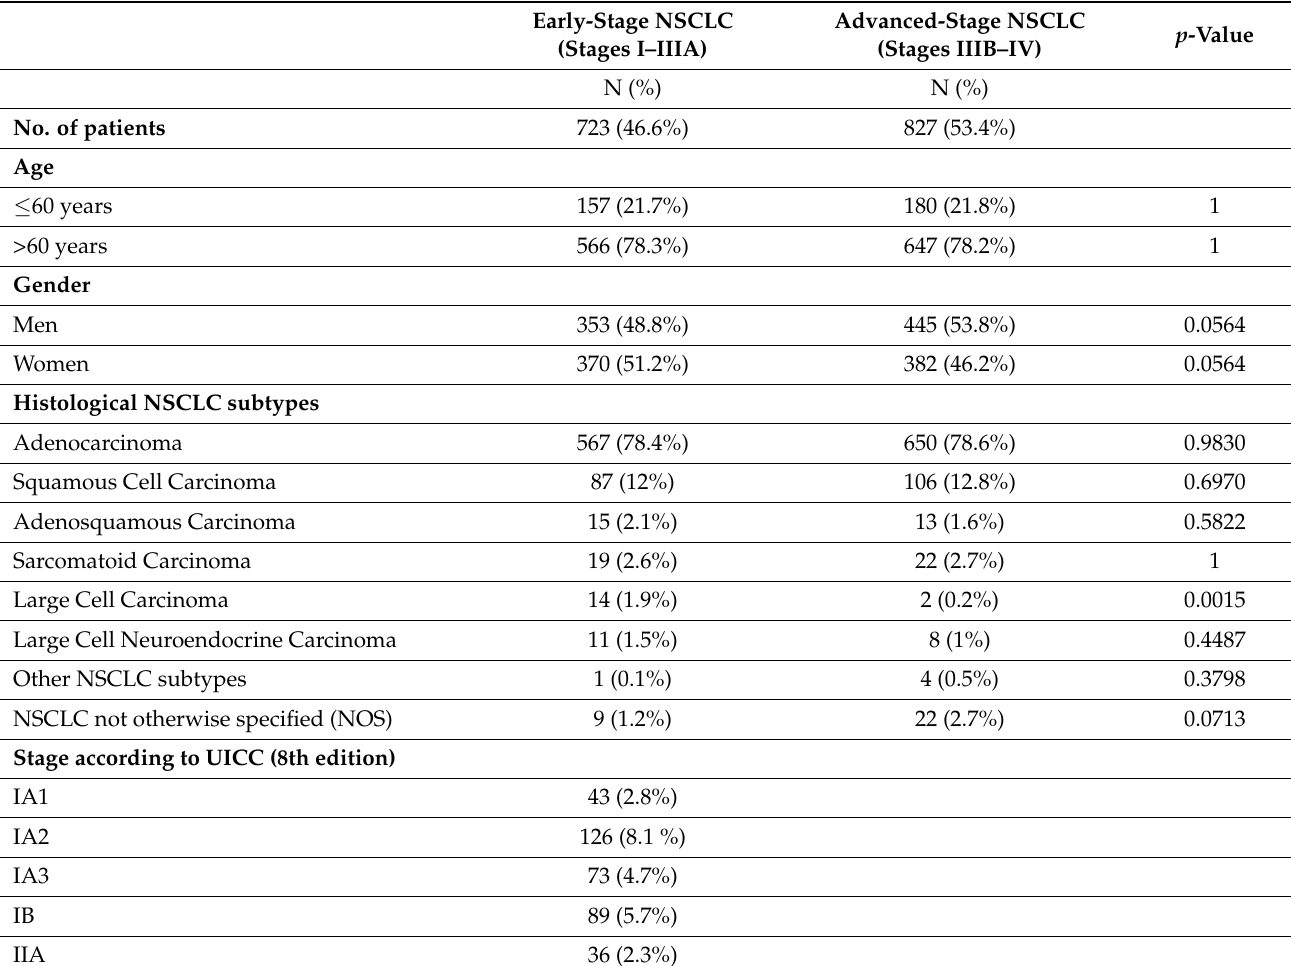
Table 1. Baseline patient